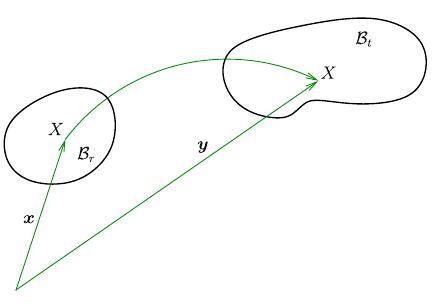
Figure 1. Deformation due to application of boundary displacement and boundary traction. B r is the reference (undeformed) configuration, B t is the current configuration, x and y are, respectively, the position vectors of X in the reference and current configurations, where X represents a generic particle of the solid